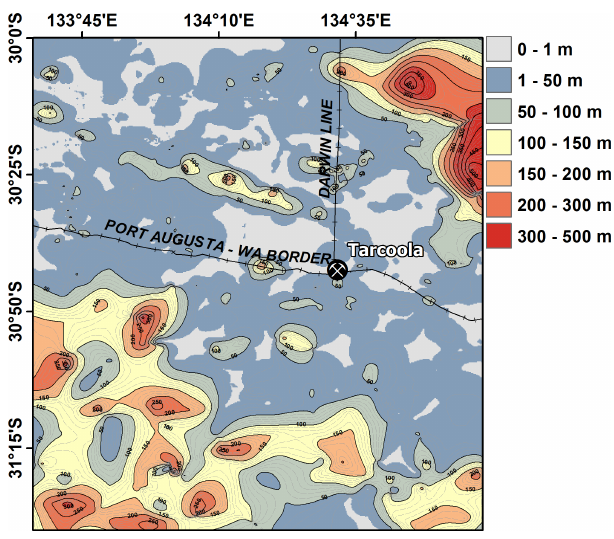
Figure 4. Depth to basement map (Cowley et al.,